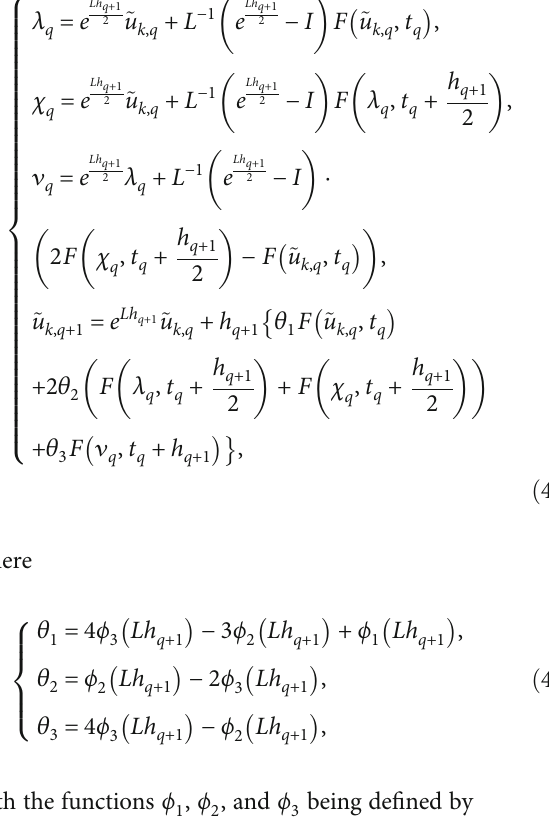
Figure 1: The log-errors (in l ∞ sense) vs. N for Example 1. Table 2: Errors in temporal direction for Example